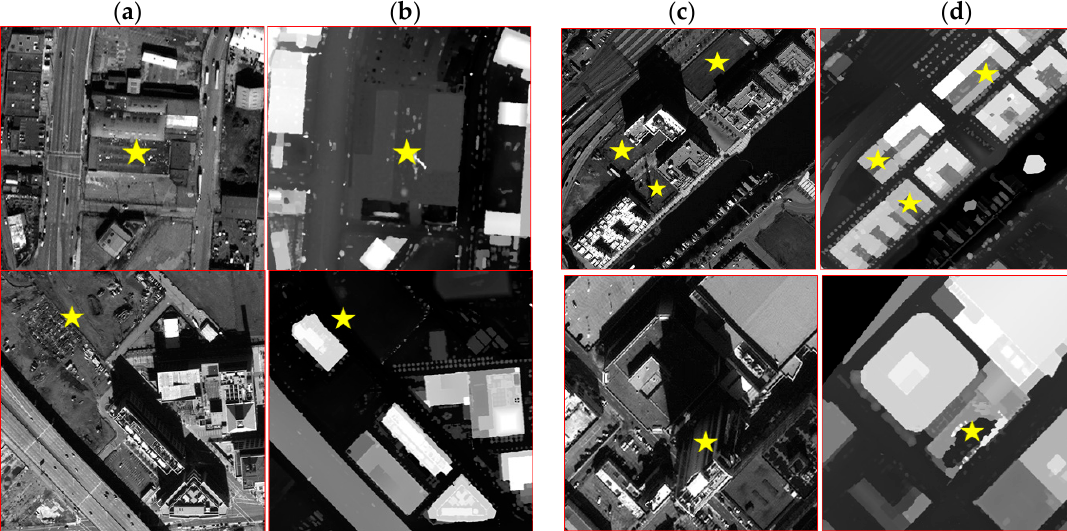
Figure 2. ( a – d ) Some of the salient urban changes occur between the time of QB and LiDAR data acquisition: Columns of ( a , c ) are QB panchromatic images and columns of ( b , d ) are corresponding LiDAR data. Changed regions are marked with the yellow stars.